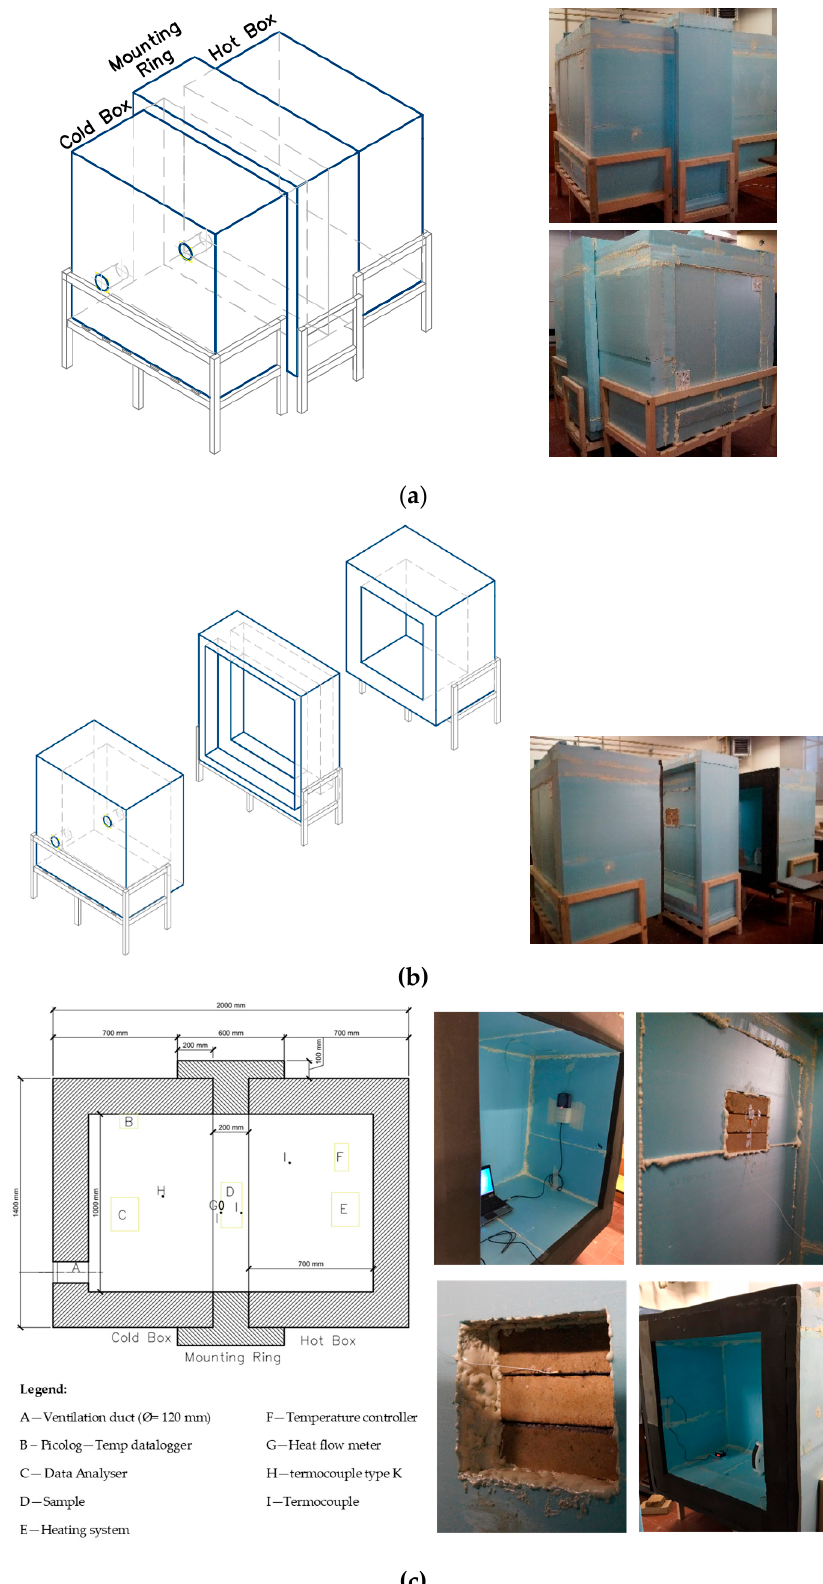
Figure 7. Hot box apparatus. Legend: ( a ) hotbox closed; ( b ) cold chamber, mounting ring, and hot chamber; ( c ) longitudinal plan view of the hotbox apparatus and position of the measurement equipment.